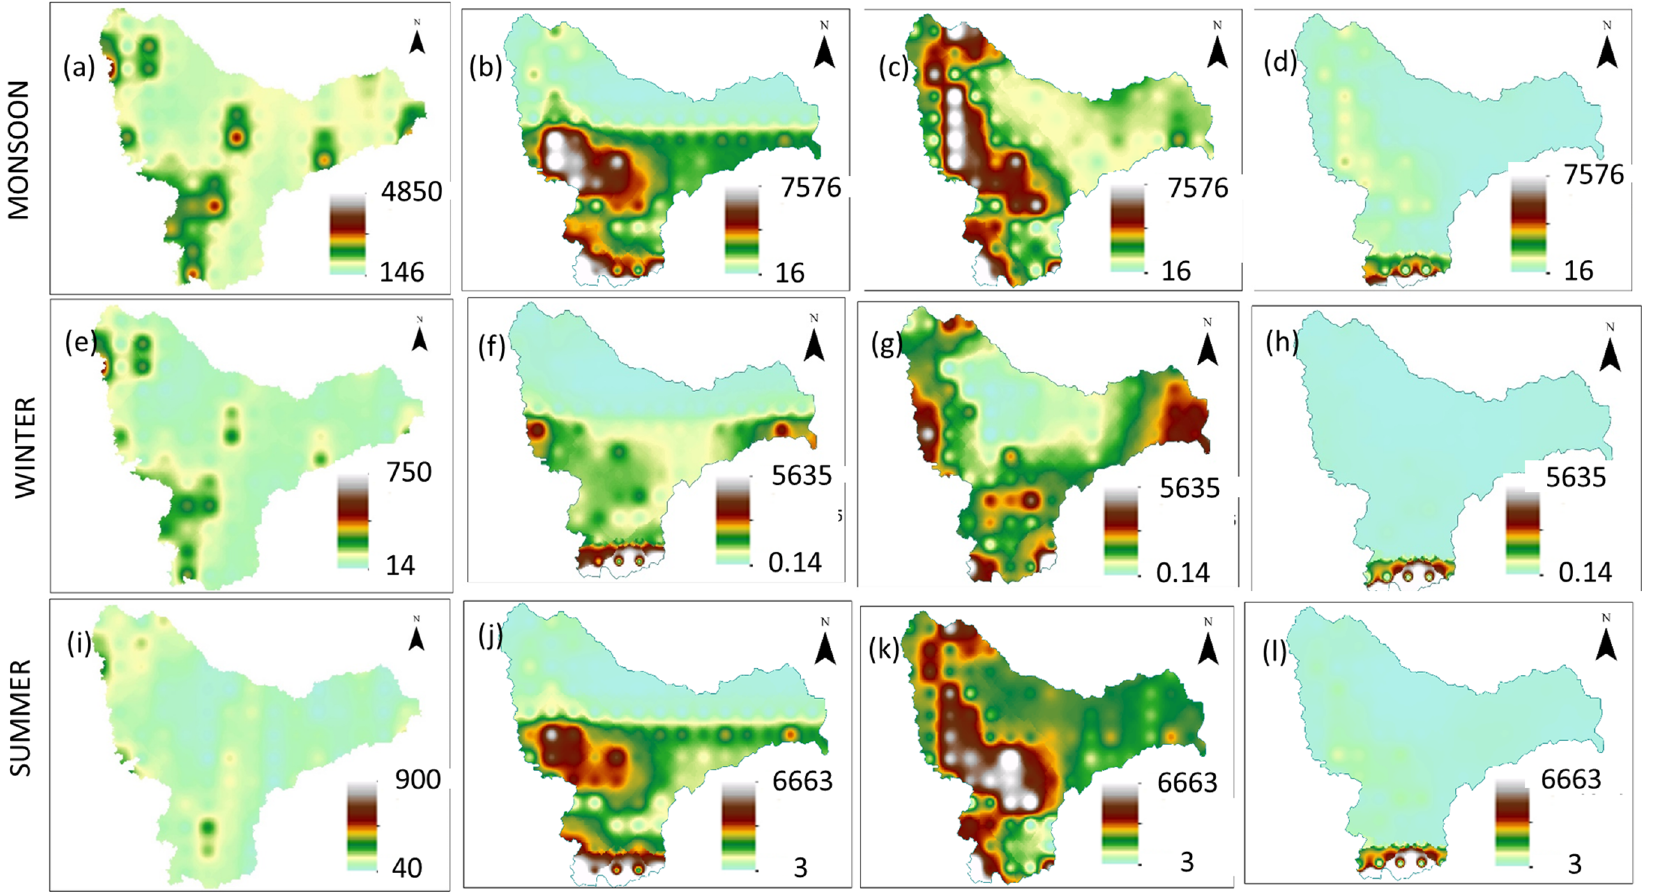
Figure 6. Seasonal average precipitation variation in the Krishna basin for Historic, Future1, Future2, and Future3 periods of Monsoon ( a – d ), winter ( e – h ) and summer ( i – l ) under the RCP 8.5 scenario.